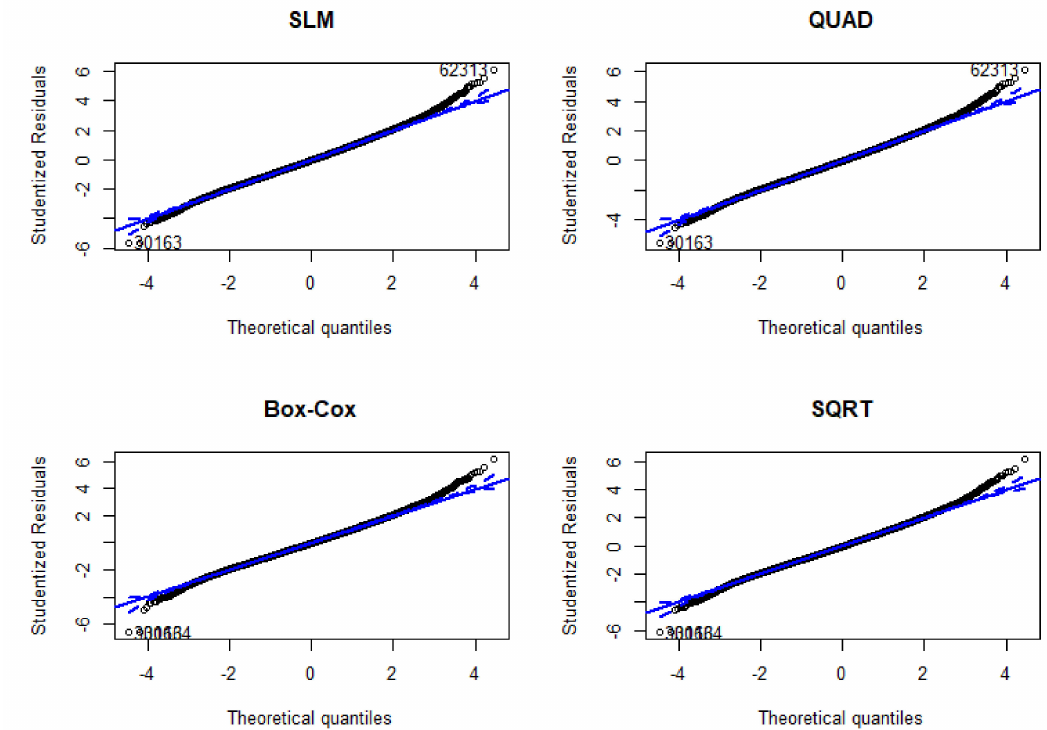
Figure A2. Normal quantile plots of the studentized residuals for all four models (SLM, QUAD, Box-Cox, SQRT) using BCS (1–5) to predict liveweight (kg). Solid blue line indicates simulated robust regression. Dotted lines indicate the confidence envelope estimated by parametric bootstrap (repeats =